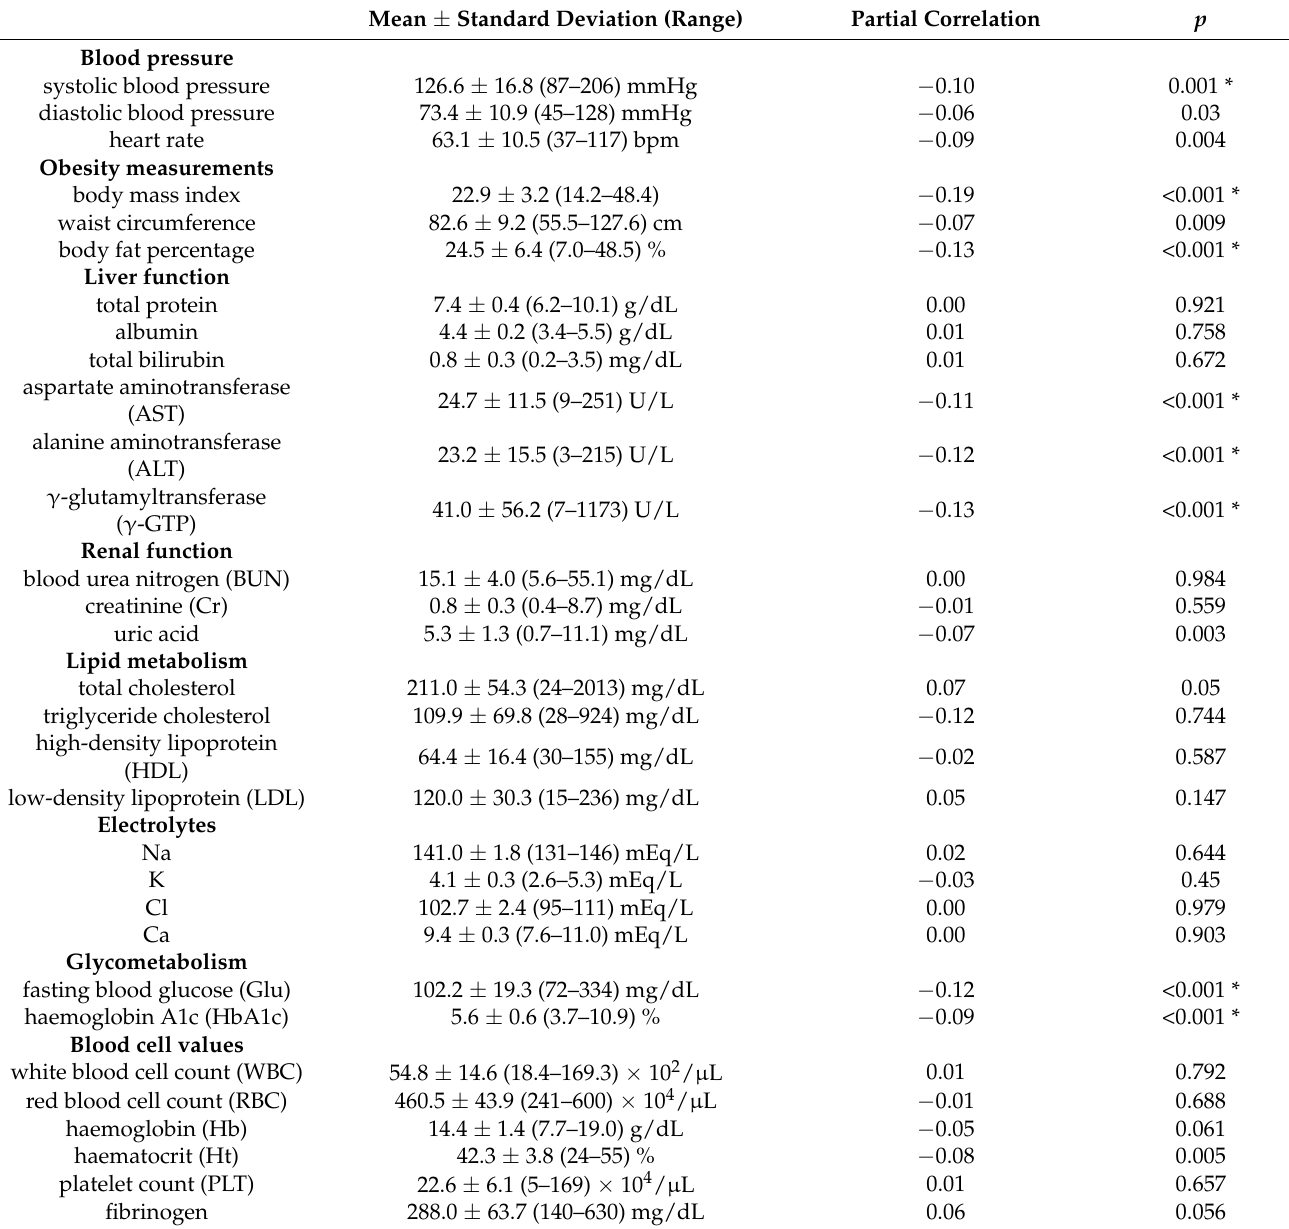
Table 2. Correlations between grey matter brain healthcare quotient and blood data, blood pressure, and obesity